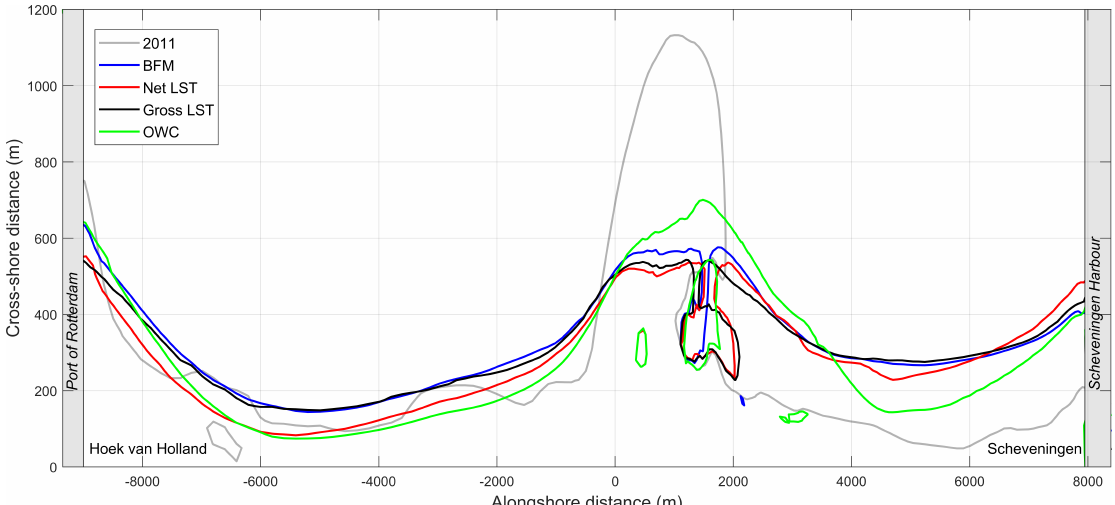
Figure 15. Predicted shoreline positions in 2040 for the four considered acceleration techniques showing the interscale